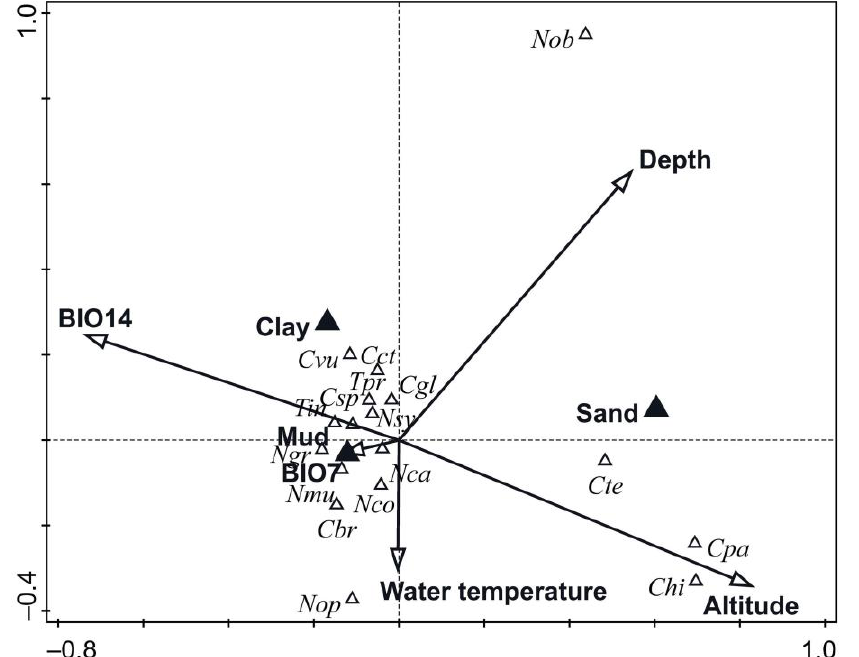
Figure 1. CCA ordination of charophytes and environmental variables in analyzed water bodies in Vojvodina (Serbia). Abbreviations of significant variables ( p < 0.05) besides Altitude, Depth, Substrate and Water Temperature: BIO7—Temperature Annual Range, BIO14—Precipitation of Driest